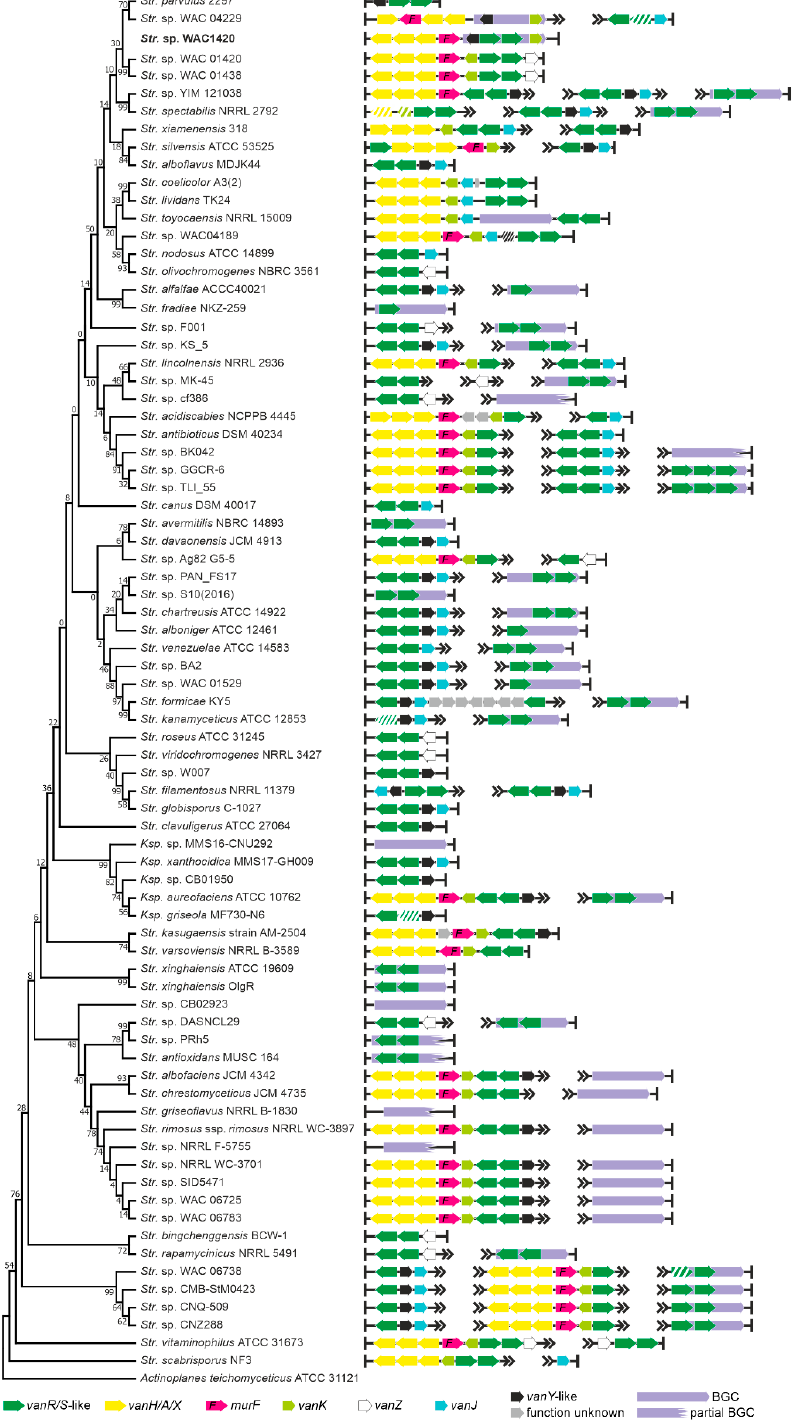
Figure 5. Organization of vlgs found within the set of 74 chosen genomes of Streptomycetales spp. Maximum Likelihood phylogenetic tree of the 16S rRNA genes of the corresponding species (see Section 4 for details) served as a phylogenetic framework for the scheme. Names of the Streptomyc- etales genera were abbreviated according to ESM Table S1. We were unable to detect the BGC for pekiskomycin within the published genome assembly of Streptomyces sp. WAC 01420, although the assembly contained vlgs ; thus, vlgs in pekiksomycin BGC (as published in [49]) are given outside of the phylogenetic framework (highlighted in bold). Please refer to the text for the role of the single genes. Legend below the figure explains the color-coding of the scheme. Pseudogenes are